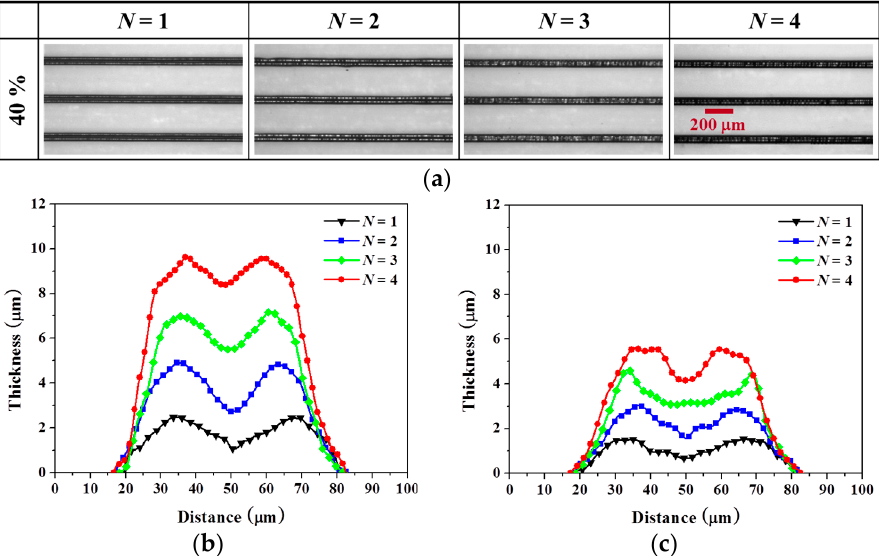
Figure 12. Microscopic images ( a ) and morphologies ( b ) after drying and ( c ) after sintering of inkjet-printed lines on S 50 substrate for different numbers of printings ( N ) at 120 °C substrate temperature when using continuous printing procedure.